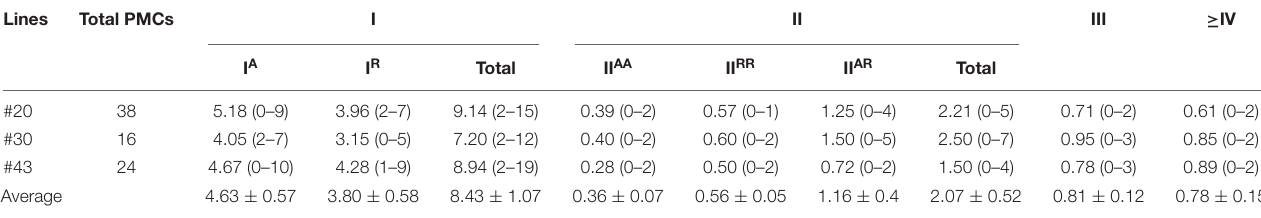
TABLE 1 | Chromosome associations in PMCs of allodiploids at diakinesis as revealed by GISH.